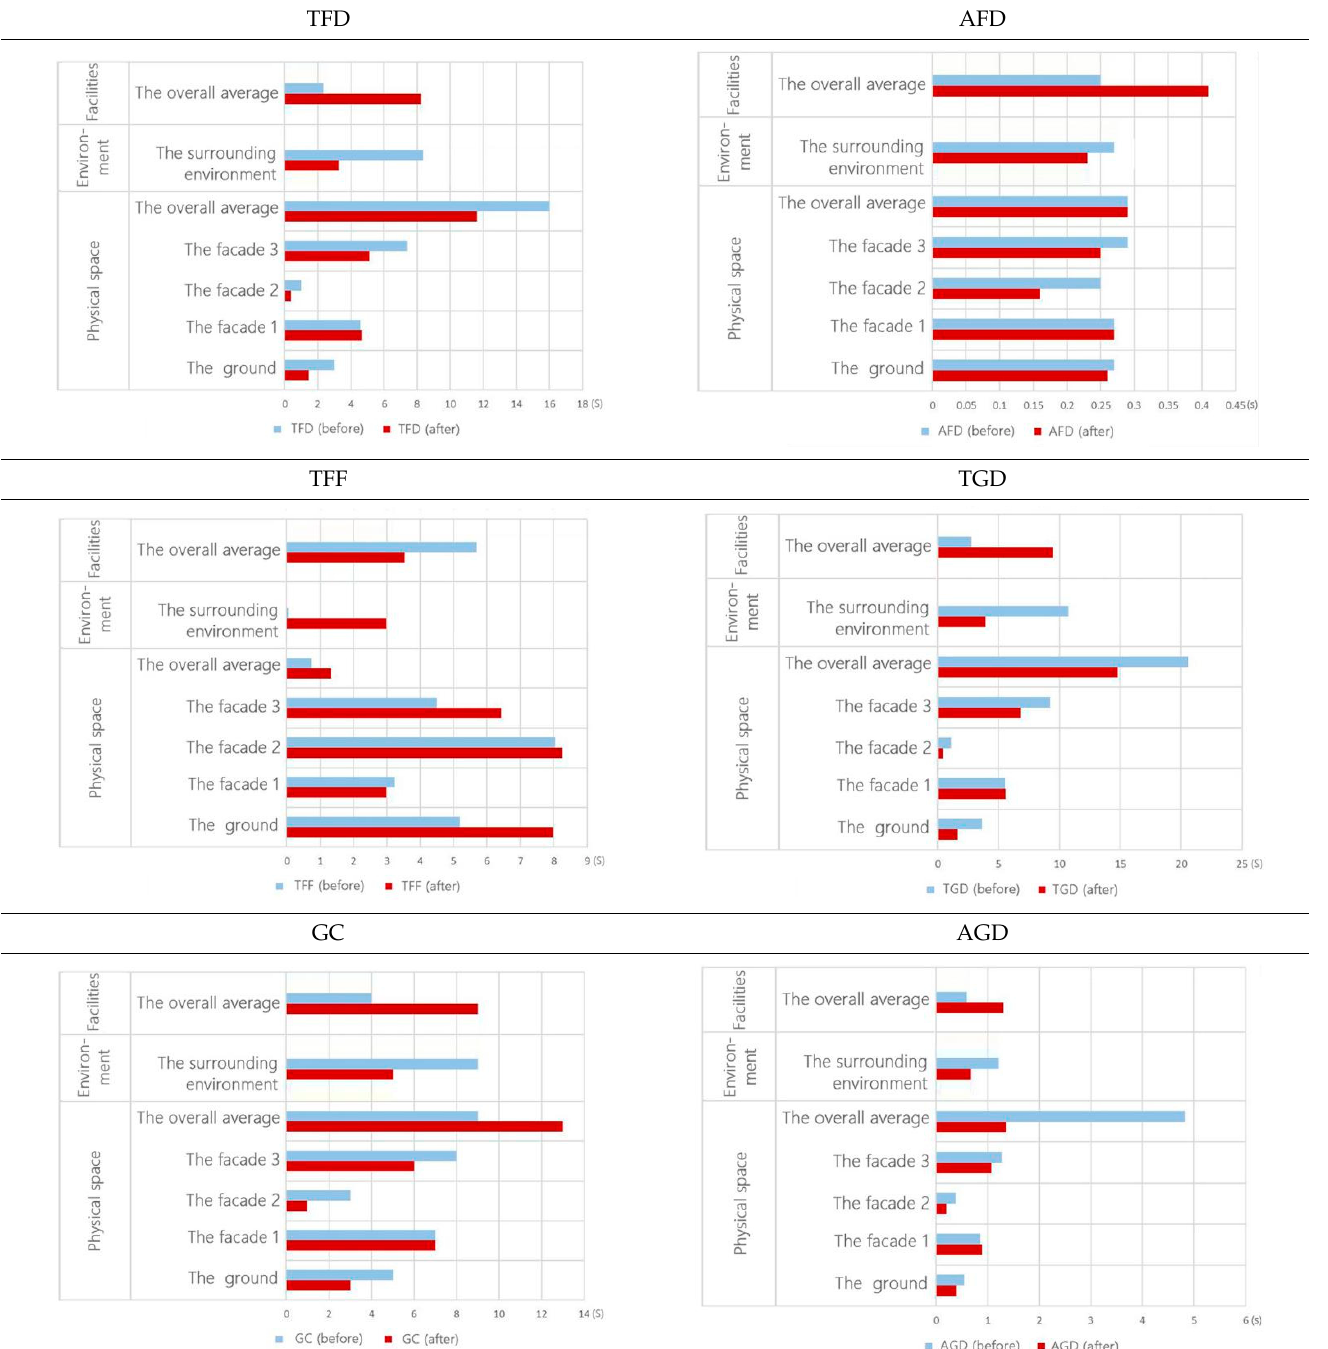
Table 3. Comparison of eye-tracking data of the third-floor terrace before and after optimization. TFD AFD